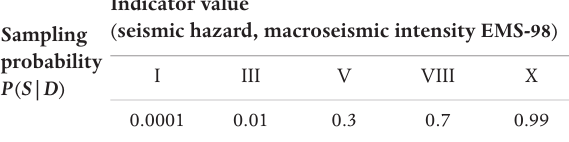
Table 7. Associations between hazard values and desired sampling probability values for the determination of the mapping parame- ters. Hazard is expressed in terms of